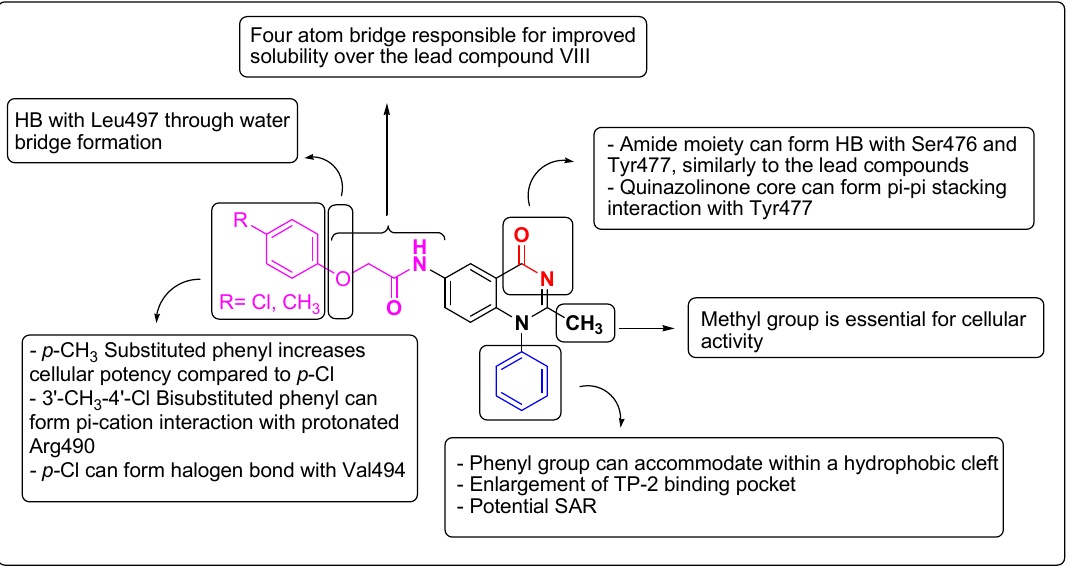
Figure 11. Plausible SAR of the target synthesized compounds 11a–f .